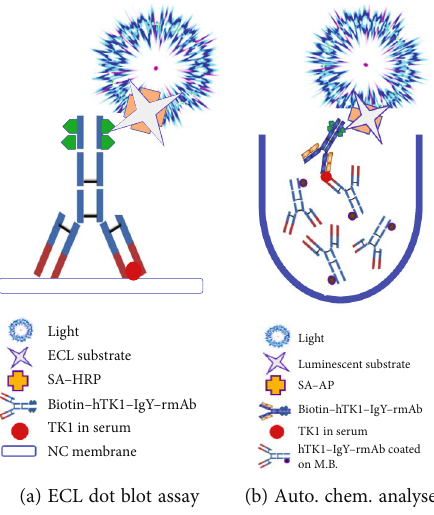
Figure 2: Schematic diagram of the two-assay system using hTK1- IgY-rmAb. The detection of STK1p using hTK1-IgY-rmAb on the semiautomatic ECL dot blot assay with BSA platform (a) and the novel automatic chemiluminescence analyser with sandwich-BSA platform (b). M.B.: magnetic